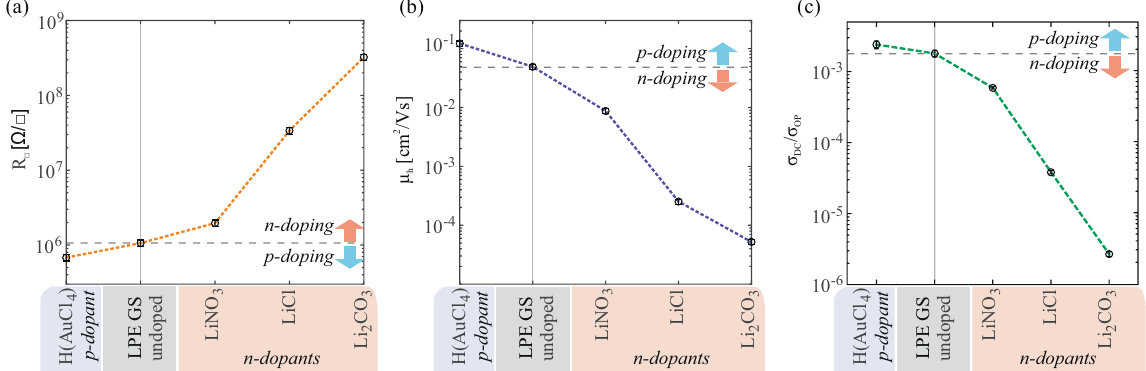
Figure 7. The dependence of the electrical properties of LBA graphene films on the type of metal standard solution based doping; ( a ) sheet resistance, and ( b ) apparent linear hole mobility, and ( c ) direct current conductivity to optical conductivity ratio ( σ DC / σ OP ). Dashed lines in ( a – c ) serve only as a guide for the